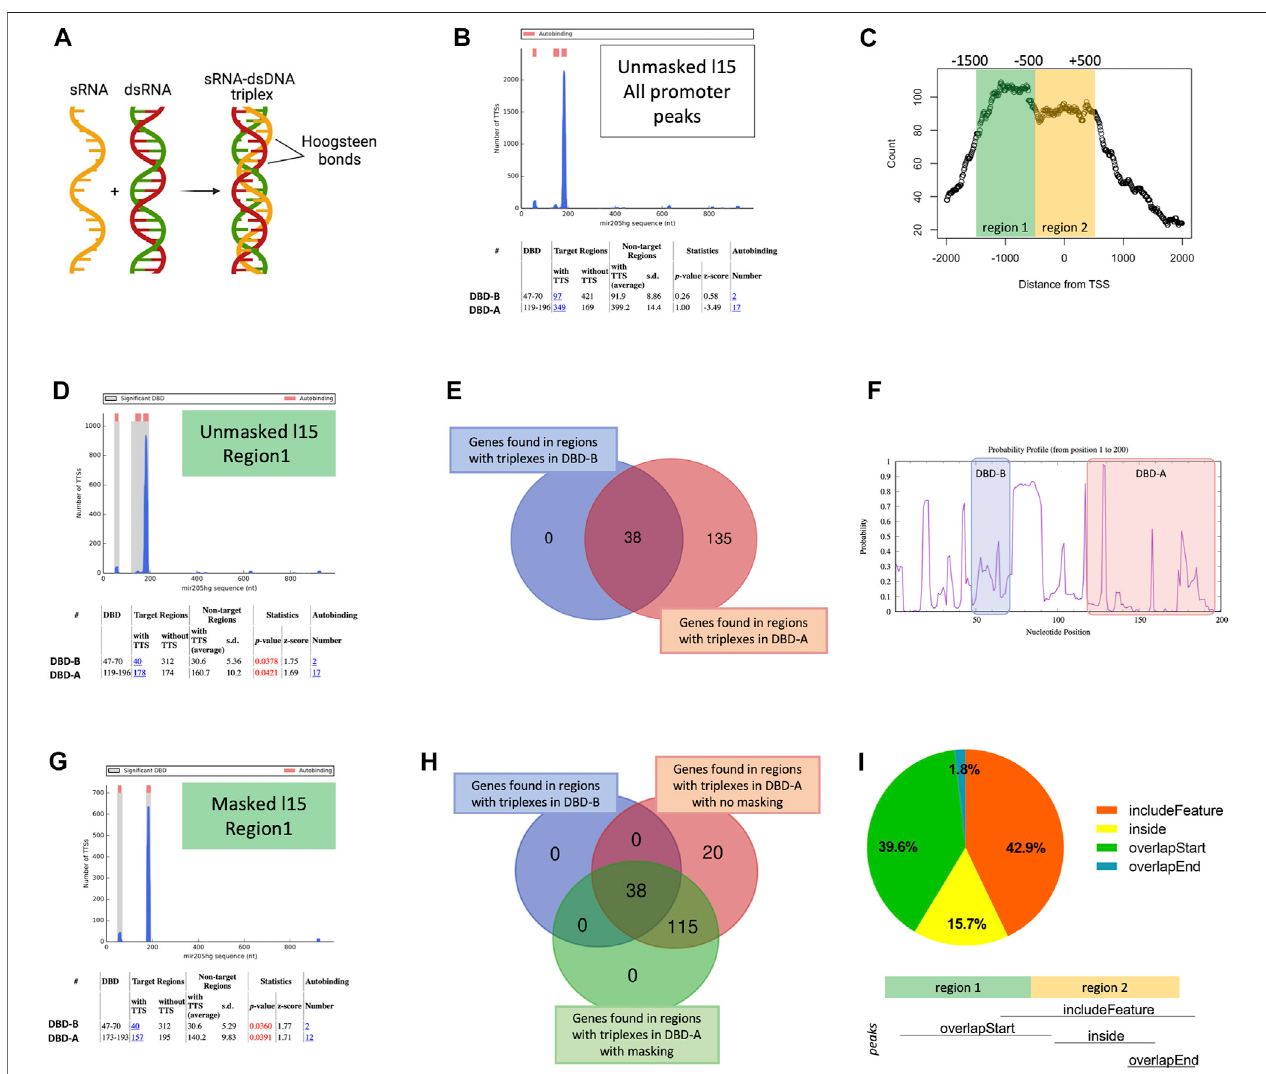
FIGURE2| Enrichmentoftriplexesin MIR205HG proximal regionpeaks. (A) RepresentationofRNA/DNAtriplexformation(created withBioRender.com). (B) TDF output for the unmasked analysis with minimum triplex length equal to 15 performed on 518 MIR205HG proximal region peaks. (C) Bimodal distribution of MIR205HG proximal region peaks around the TSS, generated using the binOverFeature function of the ChIPpeakAnno R package (v3.28.1). (D) TDF output of the unmasked analysis with minimum triplex length equal to 15 performed on “ region 1 ” -cutpeaks. (E) Intersection between genes forming a triplex with 119 – 196 DBD-A (173) andgenesformingatriplexwith47 – 70DBD-B(38)of MIR205HG transcript. (F) Pro fi leshowingtheprobabilityof MIR205HG bases(formbaseposition1to200)ofbeing single stranded. The DBD-B and DBD-A are highlighted. The image was generated by Sfold tool. (G) TDF output of the masked analysis with minimum triplex length equalto15performedon “ region1 ” -cutpeaks. (H) IntersectionbetweengenesformingatriplexwithDBD-A(173)of MIR205HG withnomasking,genesformingatriplex with DBD-B (38) and with 173 – 196 DBD-A with masking. (I) Degree of overlap between whole peaks and region 2 ( − 500/+500 bp from TSS) calculated using the fi ndOverlappingPeaks functionofthe ChIPpeakAnno Rpackage(v3.28.1).Resultsshowthat42.9%ofpeaksincludedregion2completely,thoughstartingbefore(i.e.,in region 1). This is indicated in the fi gure as “ includeFeature ” . 39.6% of peaks fell mainly in region 1, only overlapping with the start of region 2 ( “ overlapstart ” ); 15.7% fell completely within region 2 ( “ inside ” ); 1.8% of peaks overlapped with the end of region 2 ( “ overlapend ” ). Pie plot was generated using GraphPad prism. Venn diagrams were generated with the web accessible tool available at https://bioinformatics.psb.ugent.be/webtools/Venn/.